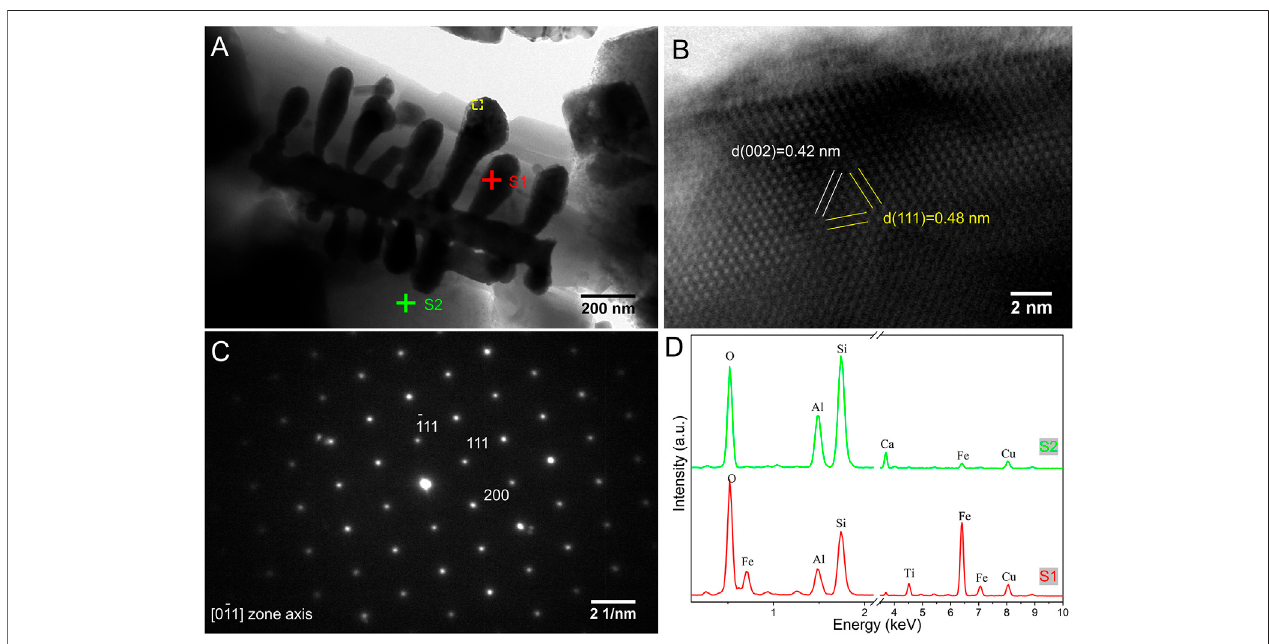
FIGURE 7 | TEM analyses of Type-5 magnetite dendrites hosted within silicates. (A) TEM image of a magnetite dendrite aggregate hosted within a silicate. (B) HRTEM image of a small region of the particle indicated by the yellow dashed box in (A) . (C) SAED pattern recorded from the [011] zone axis of the particle in (B) . (D) EDXS spectra for dendrite magnetite and the host silicate [indicated by colored crosses in (A) ].